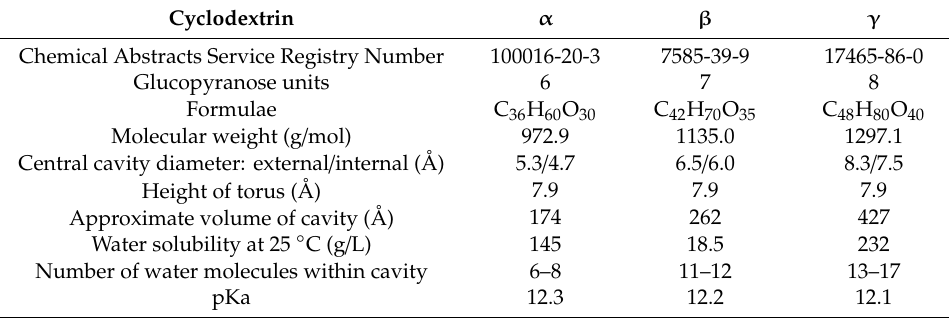
Table 1. The three native cyclodextrins and their main characteristics. Reprinted with permission from Springer Nature: Springer International Publishing AG, Cyclodextrin Fundamentals, Reactivity and Analysis by Crini et al., Reference [3], COPYRIGHT